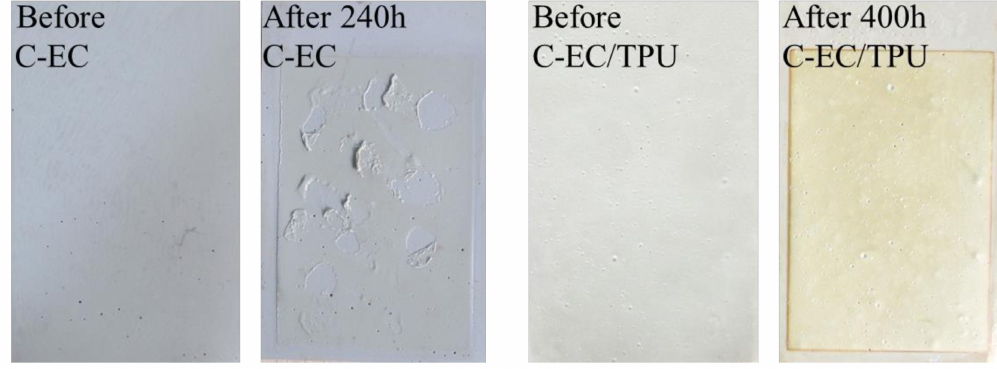
Figure 9. Surface morphology of coating samples before and after UV